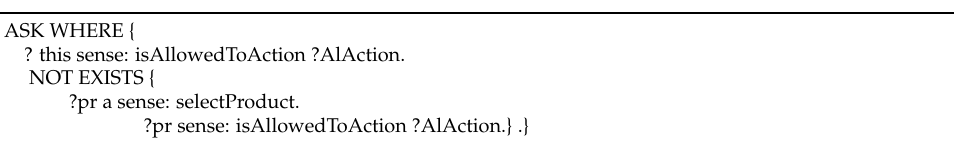
Table 12. SPIN Constraint—Shopy use